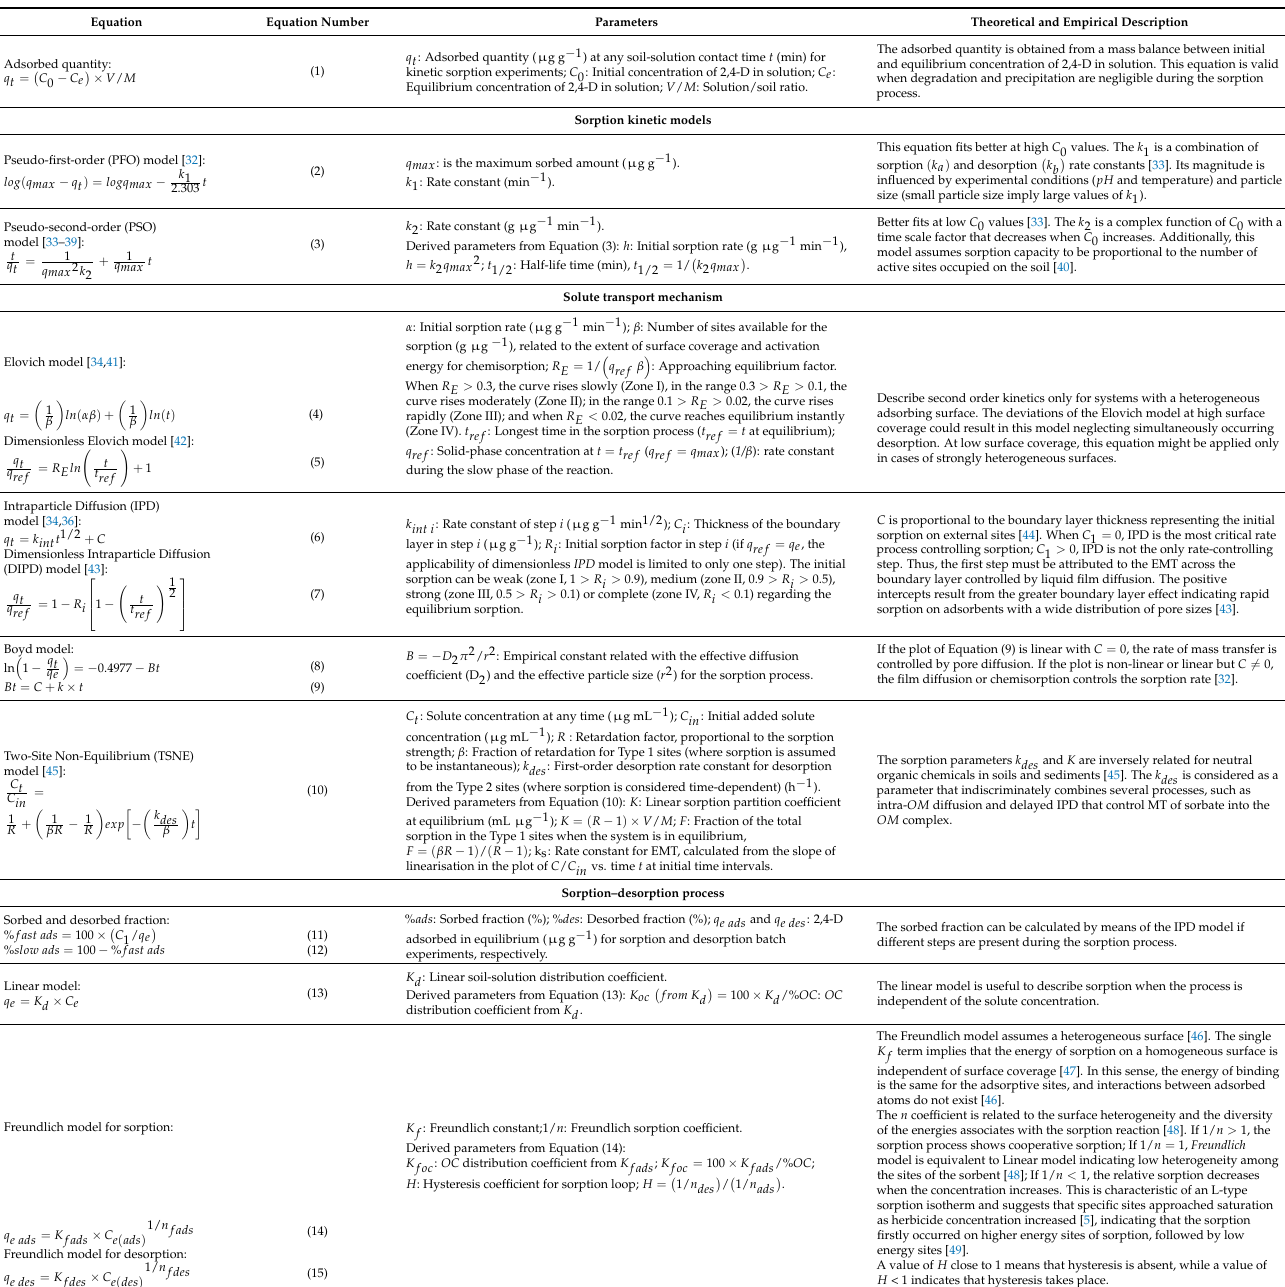
Table 3. Models used to describe sorption kinetic and sorption-desorption of 2,4-D on volcanic ash-derived soils 1 . Equation EquationNumber Parameters TheoreticalandEmpiricalDescription